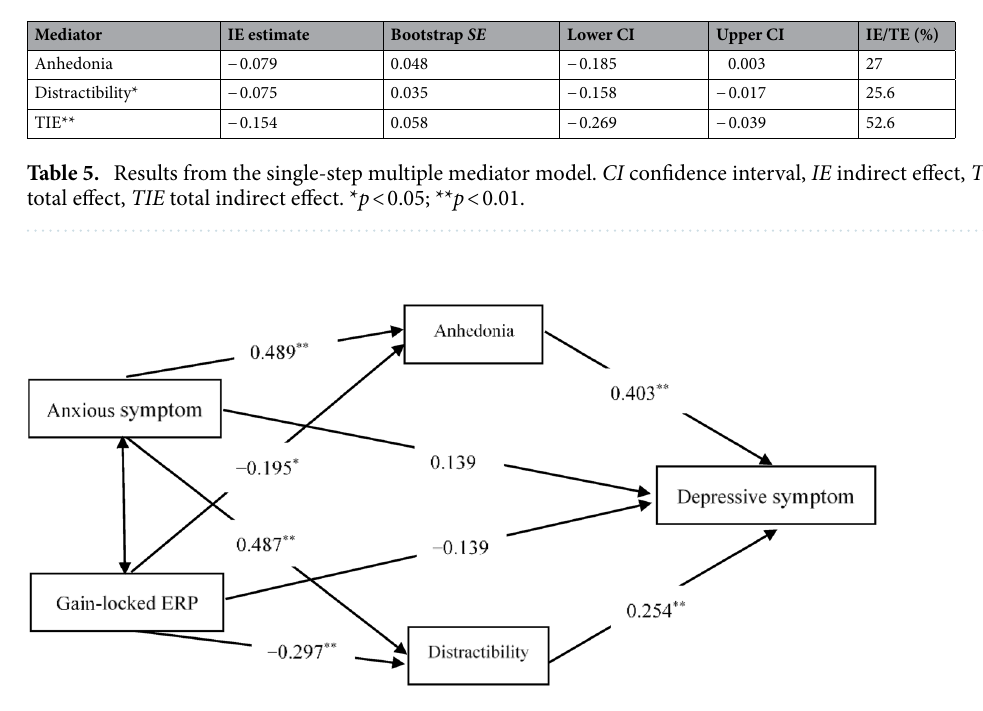
Figure 5. Single-step multiple mediator model of gain-locked ERP component and overall depressive symptoms (* p < 0.05, ** p <